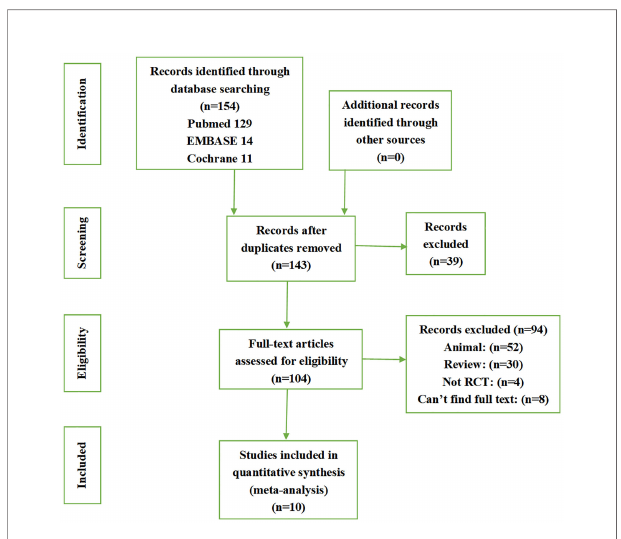
FIGURE 1 | Flow chart of search